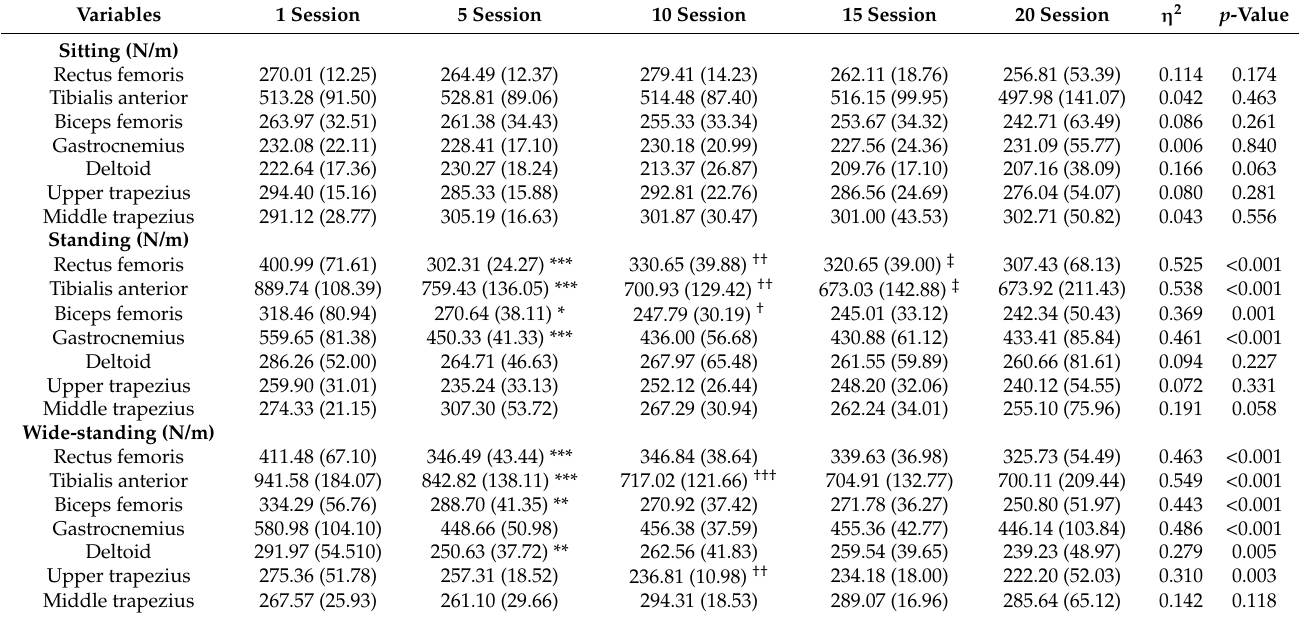
Table A4. Muscle stiffness during the locomotion training